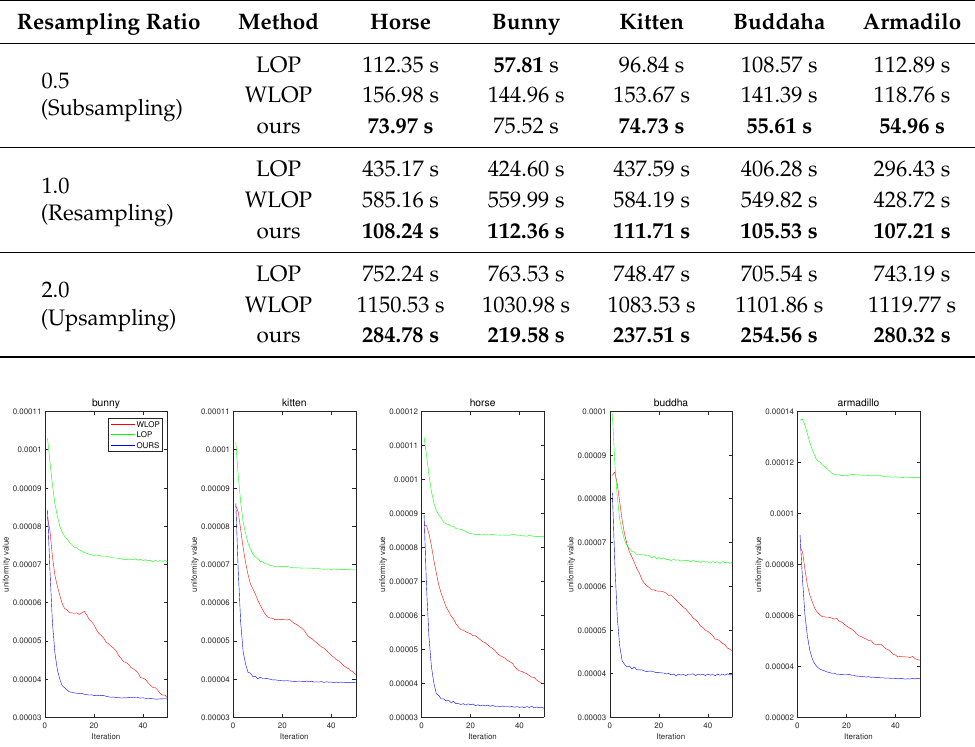
Figure 22. Convergence results of compared methods for the resampling experiment with tangential case. (first column: Horse, second column: Bunny, third column: Kitten, fourth column: Buddha, and fifth column: